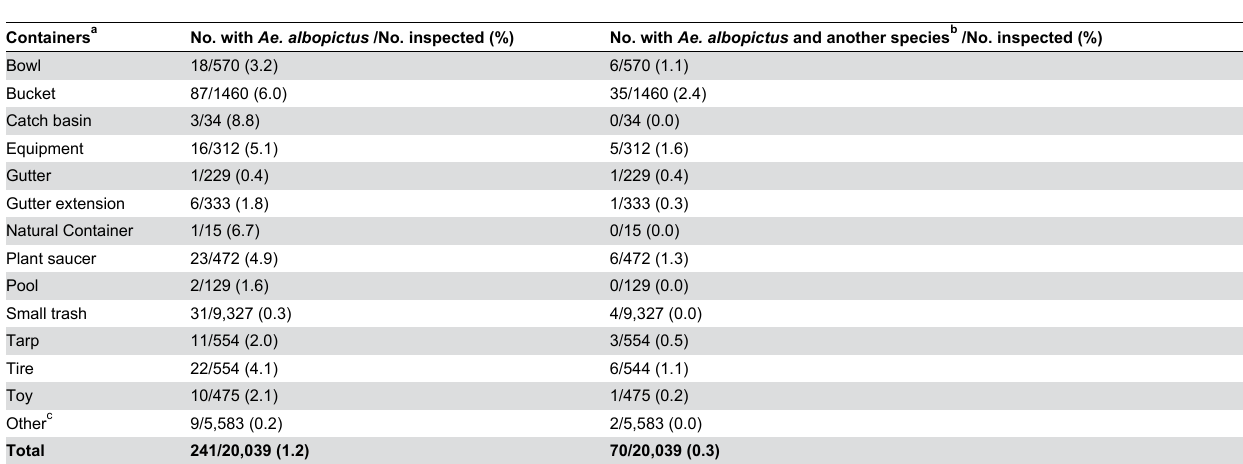
Table 1. Summary of the occurrence of Aedes albopictus in the different container types.